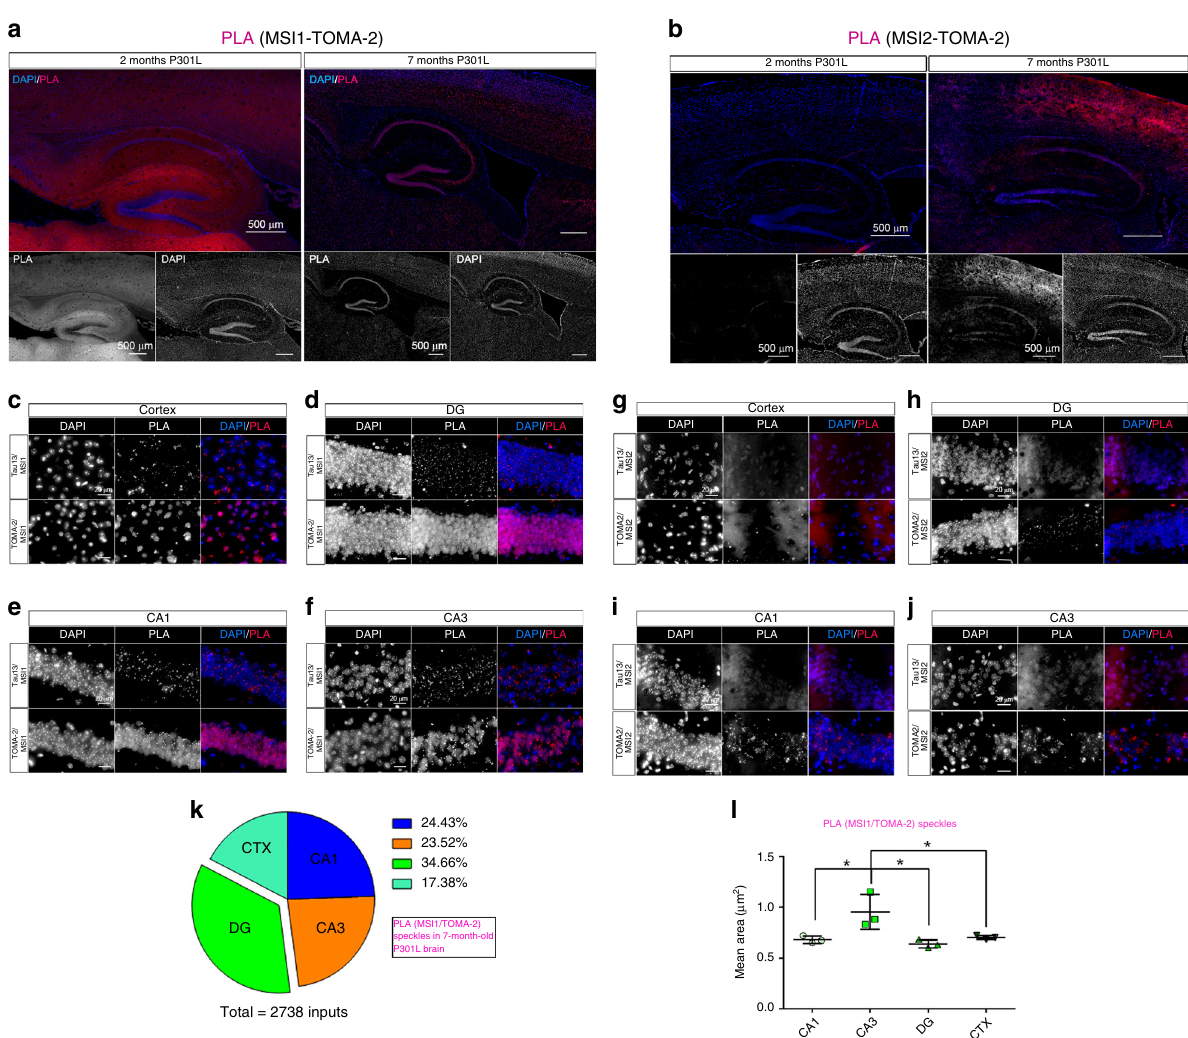
Fig. 5 MSI/tau complexes localize in P301L hippocampus and cortex nuclei in aged mice. a Representative hippocampus of 2- and 7-month-old P301L mice. PLA (MSI1-TOMA-2 combination) represented in red and DAPI (blue) stained nuclei. PLA and DAPI channels are represented in gray below the stitched panels. b Representative hippocampus of 2- and 7-month-old P301L mice. PLA (MSI2-TOMA-2 combination) represented in red and DAPI (blue) stained nuclei. PLA and DAPI channels are represented in gray below the stitched panels. 10x magni fi cation and white scale bar: 500 µ m. c Cortex 7-month PLA Tau13/MSI1 (top) and TOMA-2/MSI1 (bottom). d DG 7-month PLA Tau13/MSI1 (top) and TOMA-2/MSI1 (bottom). e CA1 7-month PLA Tau13/MSI1 (top) and TOMA-2/MSI1 (bottom). f CA3 7-month PLA Tau13/MSI1 (top) and TOMA-2/MSI1 (bottom). g Cortex 7-month PLA Tau13/MSI2 (top) and TOMA-2/MSI2 (bottom). h DG 7-month PLA Tau13/MSI2 (top) and TOMA-2/MSI2 (bottom). i CA1 7-month PLA Tau13/MSI2 (top) and TOMA-2/MSI2 (bottom). j CA3 7-month PLA Tau13/MSI2 (top) and TOMA-2/MSI2 (bottom). Magni fi cation ×100 and white scale bar: 20 µ m. k Percentage of MSI1/ TOMA-2 foci in CTX, DG, CA1 and CA3 in brains from 7-month-old mice. Percentage is represented by a pie chart. l Mean Area quanti fi cation of MSI1/ TOMA-2 foci in CTX, DG, CA1, and CA3 in brains from 7-month-old mice (one-way ANOVA, * p = 0.0106 between the columns). Three ROIs from n = 3 biologically independent examined over three independent experiments. Data are presented as mean ±